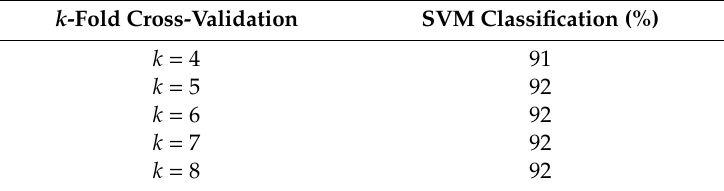
Table 5. SVM classification by k -fold cross-validation.